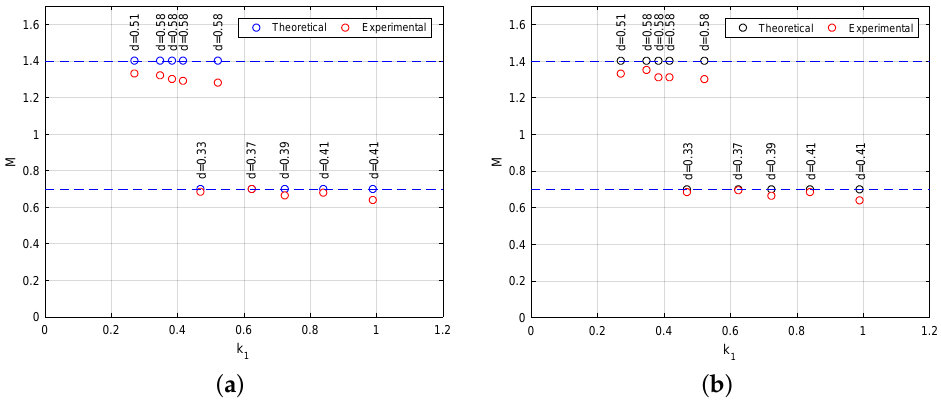
Figure 18. Theoretical and experimental comparison: ( a ) SEPIC and ( b )